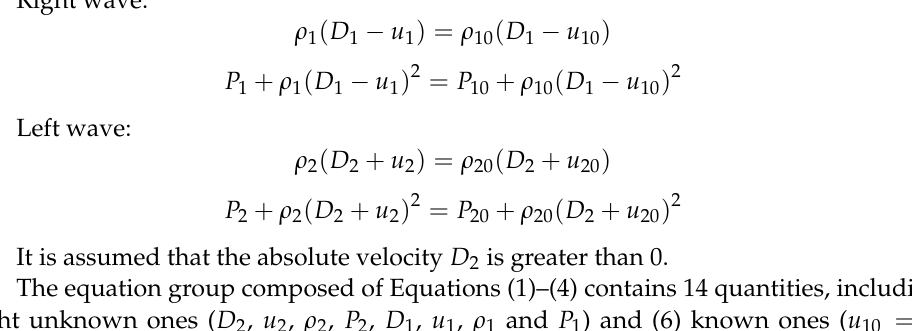
refer to the density of